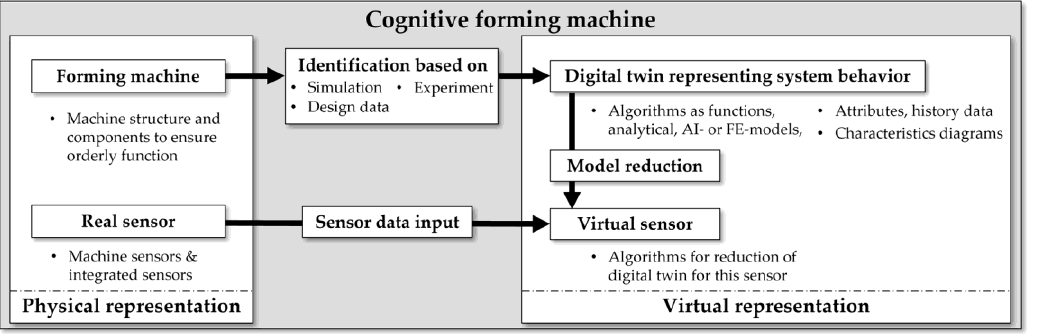
Figure 1. Basic concept of a cognitive forming machine.